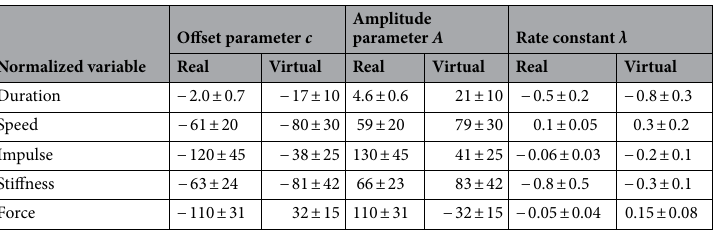
Table 1. The normalized movement duration, speed, impulse, stiffness (cocontraction in the real task, grasp force in the virtual task), and the tangential force were all fitted separately for each participant using an exponential function, whose parameters (mean and SEM) are summarized